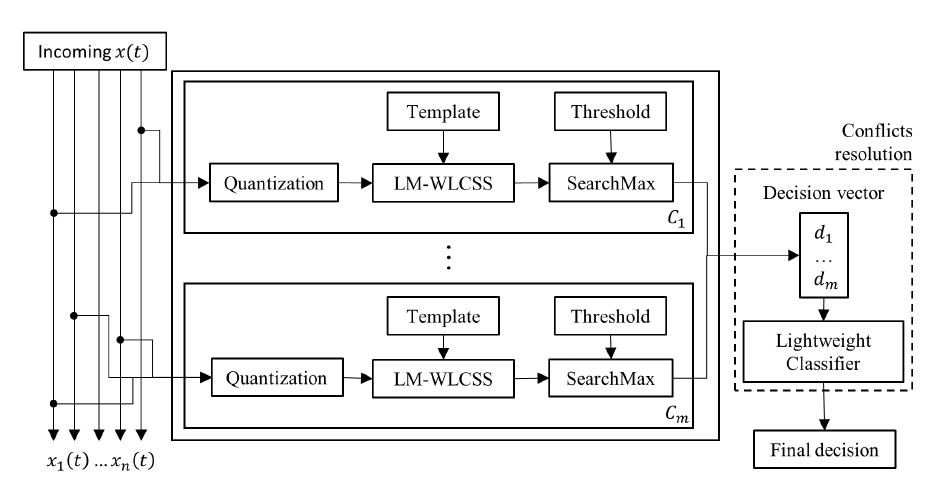
Figure 2. A multiclass gesture recognition system including multiple binary classifiers based on